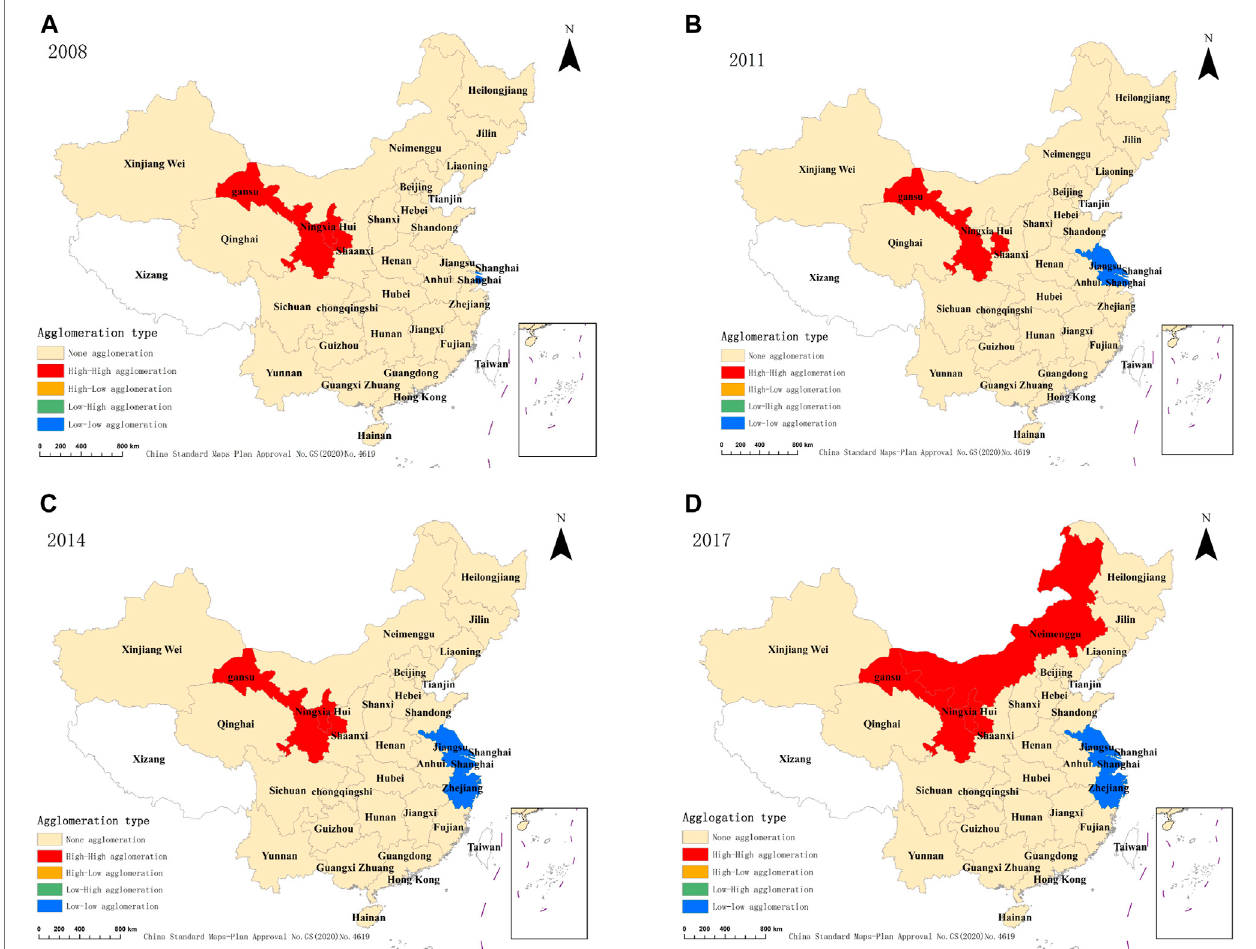
FIGURE5| LISAdiagramofUCCDbetweenSTDLandLCEE. (A) China ’ sprovincialLISAdiagramin2008; (B) China ’ sprovincialLISAdiagramin2011; (C) China ’ s provincial LISA diagram in 2014; (D) China ’ s provincial LISA diagram in 2017.